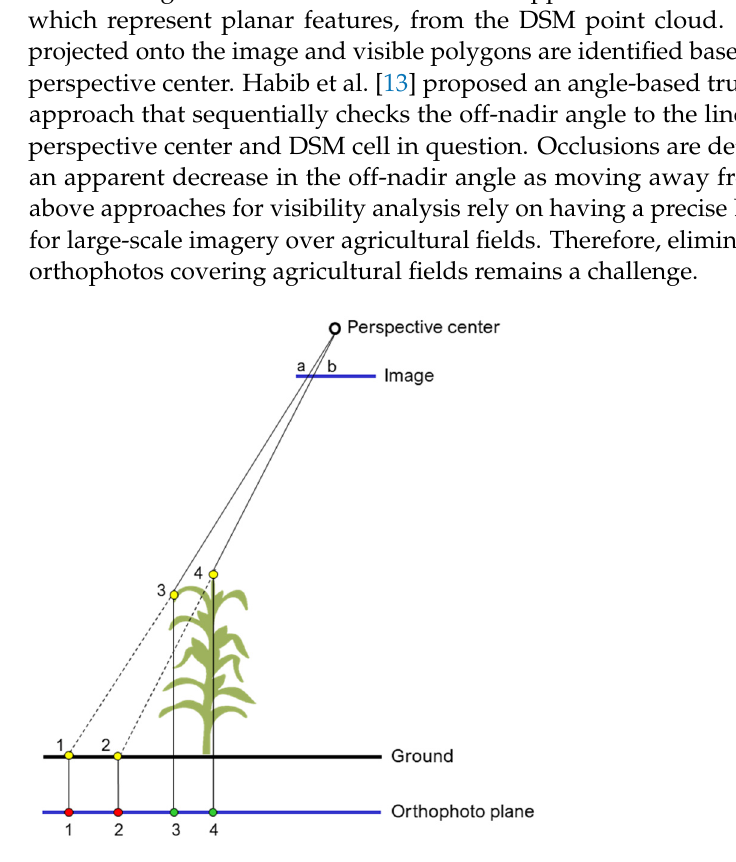
Figure 2. A schematic diagram of double mapping where sudden object space elevation variations cause duplicated spectral signatures in the orthophoto.